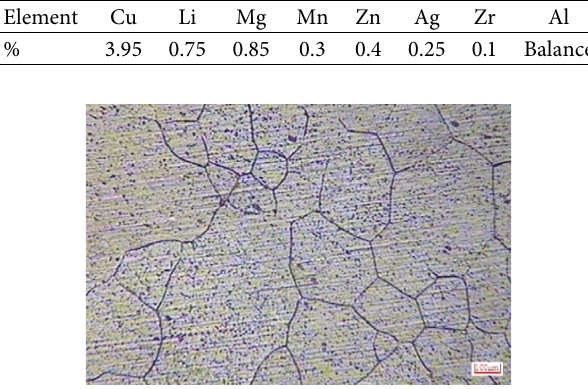
Figure 1: Metallographic image of 2060-T8 alloy after Keller re- agent